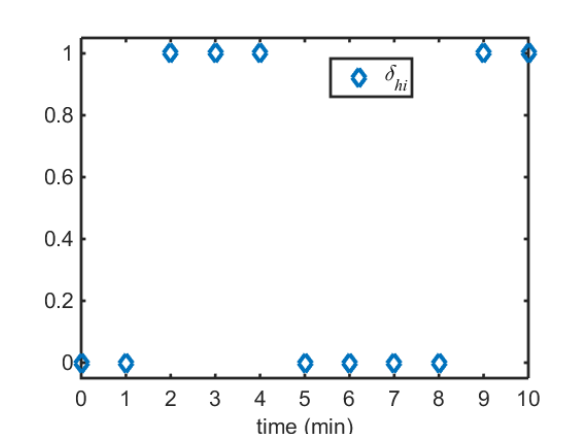
Figure 7. The pseudo-binary variable, δ hi , which is a continuous variable that takes on values of 1 (tank full) and 0 (tank empty) at the solution.